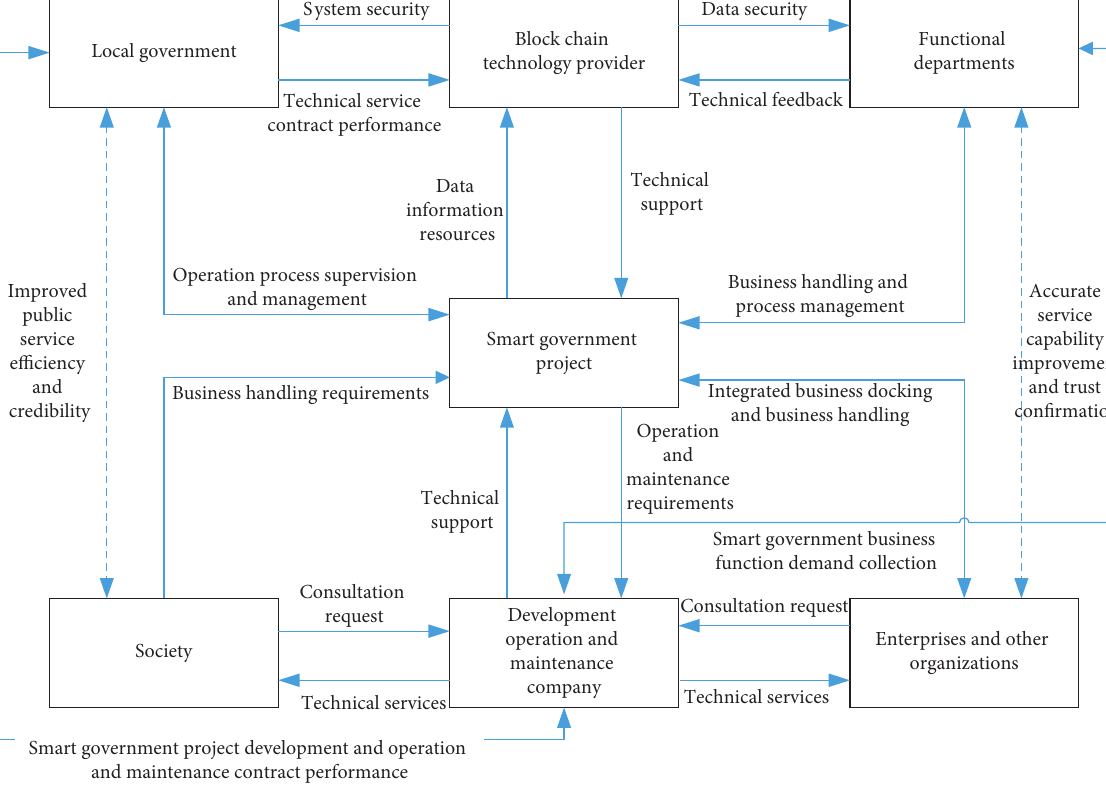
Figure 6: Framework diagram of the collaborative governance organization structure of smart government projects with blockchain